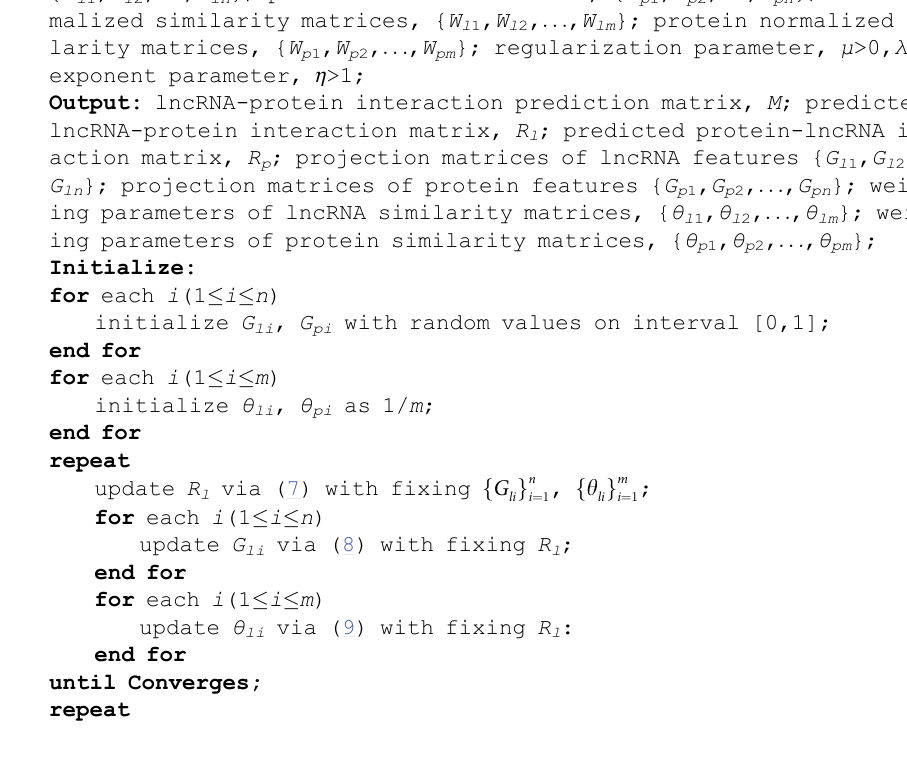
Algorithm 1 : Predicting unobserved associations between known lncRNAs and known proteins by SFPEL-LPI